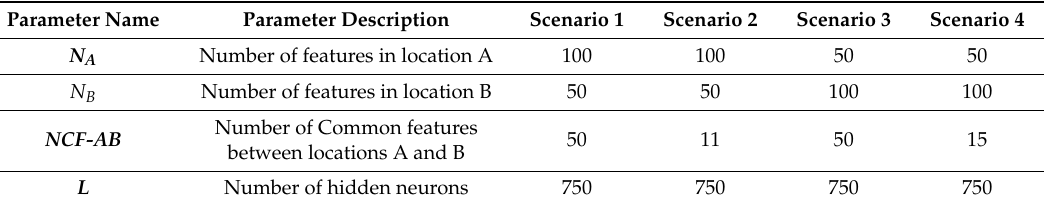
L Number of hidden neurons Table 3. Settings of testing scenarios for block size = 100 and regularization parameter C = 2 − 6 for the TampereU dataset.